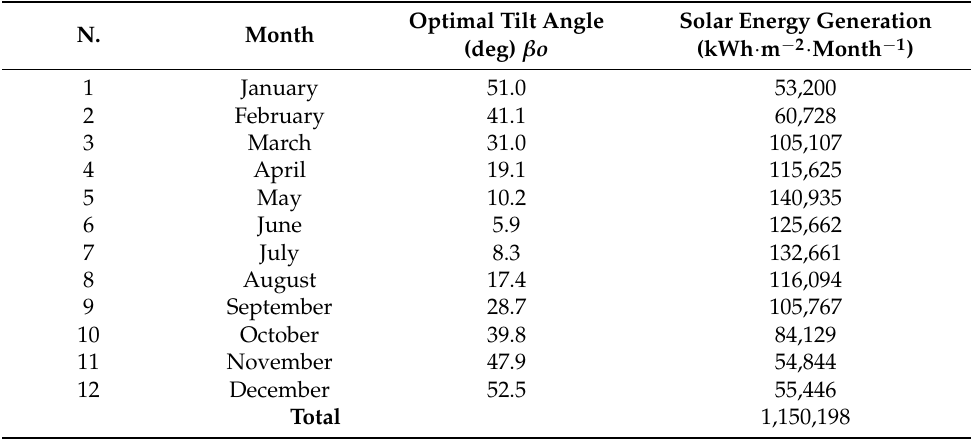
Table 3. Monthly solar energy generations by solar panels using the optimal tilt angle ( β o ). N.